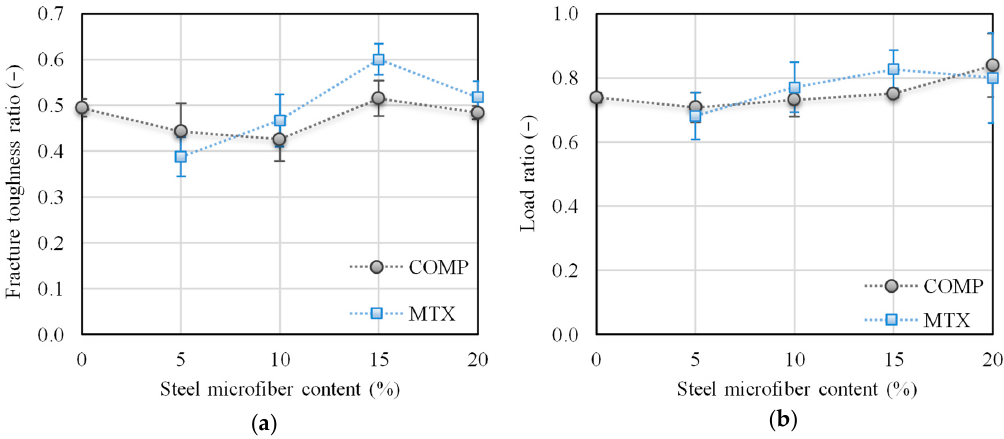
Figure 10. Fracture toughness ratio ( a ) and load ratio ( b ) of AAS mortar with different amounts of steel microfibers.